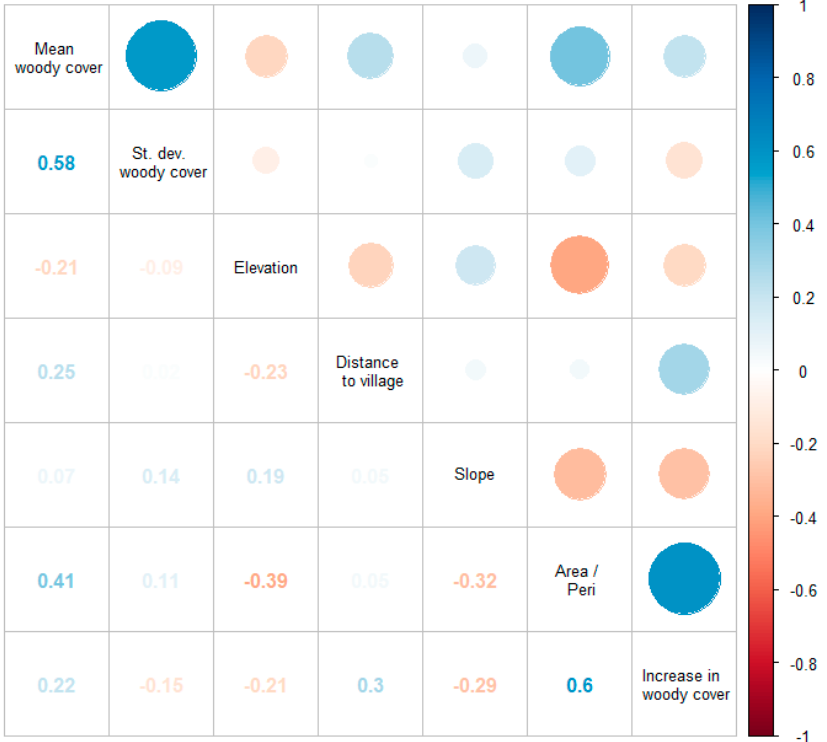
Figure 3. Correlation plot of the characteristics of the 17 exclosures in the Degua Tembien district.